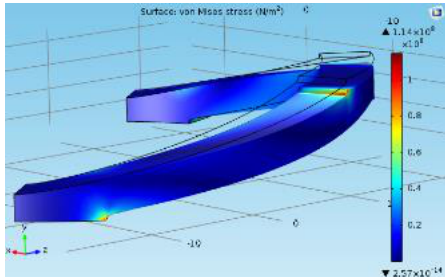
Figure 6. FEA study for a single cylindrical arch where the apex boundary is subjected to a force component.